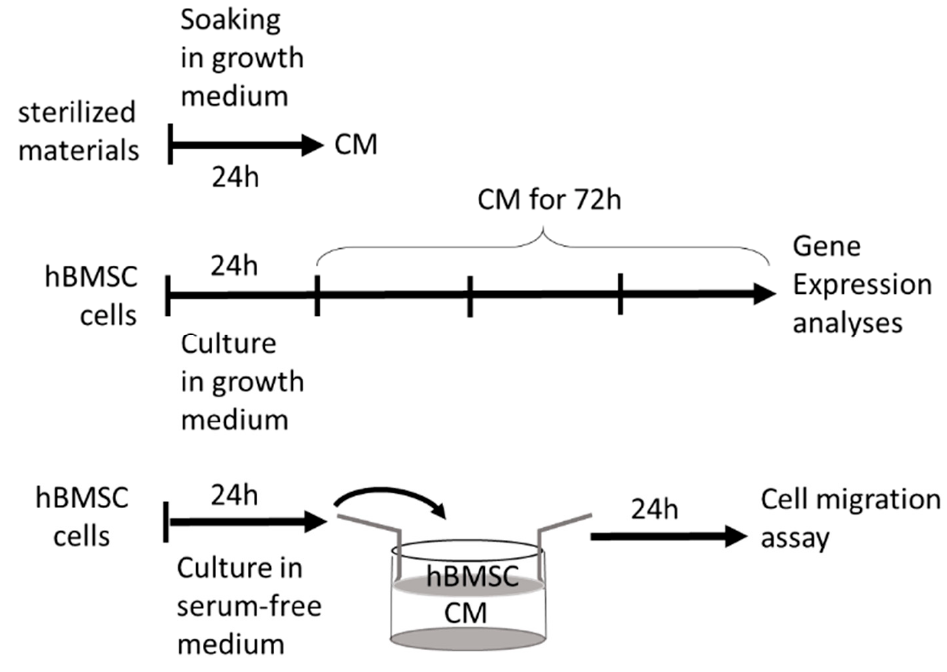
Figure 3. The scheme of experiments.